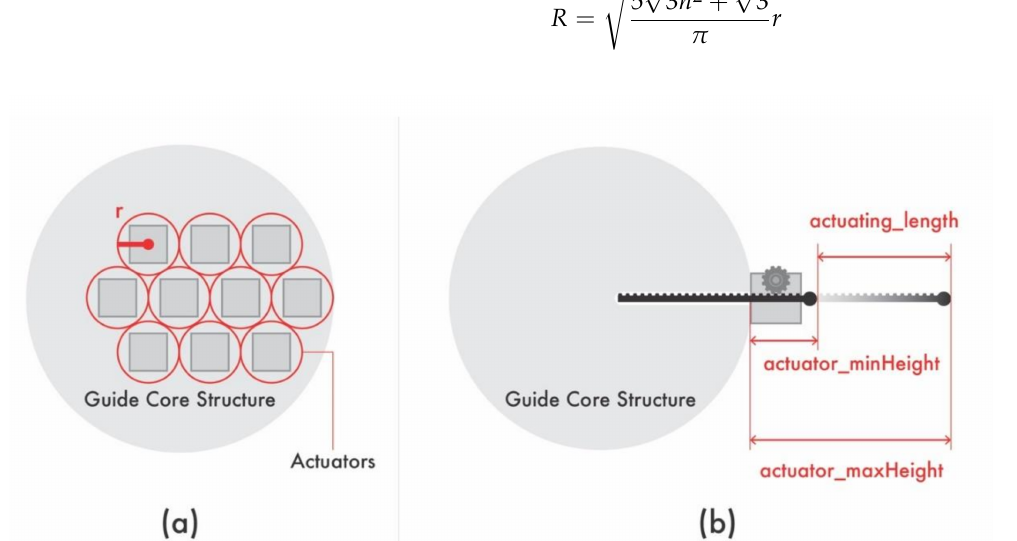
Figure 3. Assuming that the actuating pins have hexagonal packing, the dynamic range, that is, the rate of change of the total volume, can be calculated. ( a ) Example of hexagonal packing by calculating the range of influence of the actuating pins, depicted in circles; ( b ) boundary line (actuator_minHeight) at the minimum size, and the boundary line (actuator_maxHeight) at the maximum size.